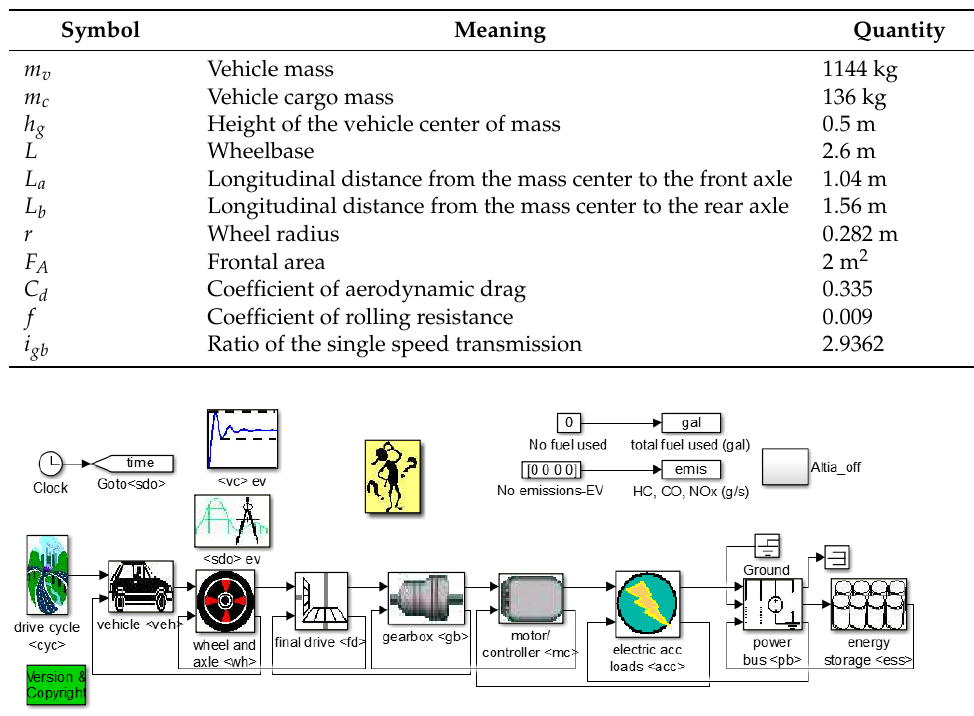
Table 1. Parameters of the considered vehicle.